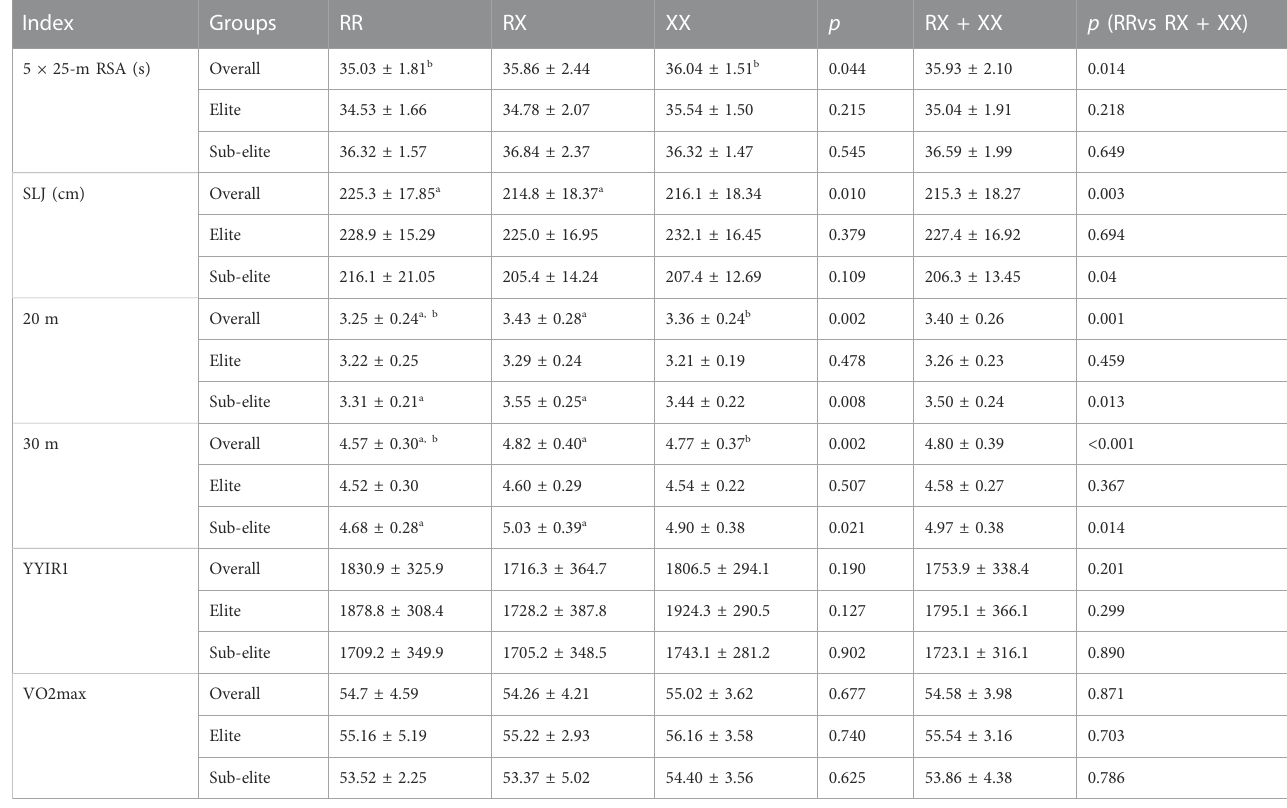
TABLE 4 Comparison of athletic performances of RR, RX and XX genotype in elite and sub-elite goalkeeper, defender, mid fi elder and forward players.